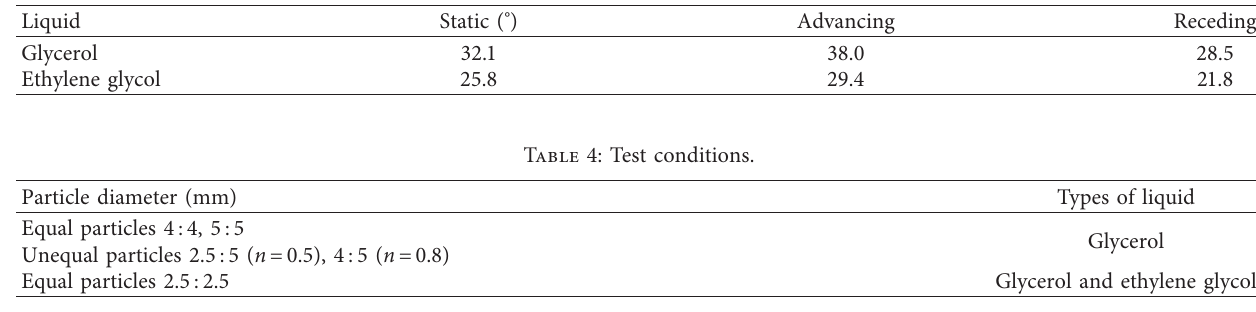
Table 3: Contact angle of liquid on the particle surfaces (20 ° C).